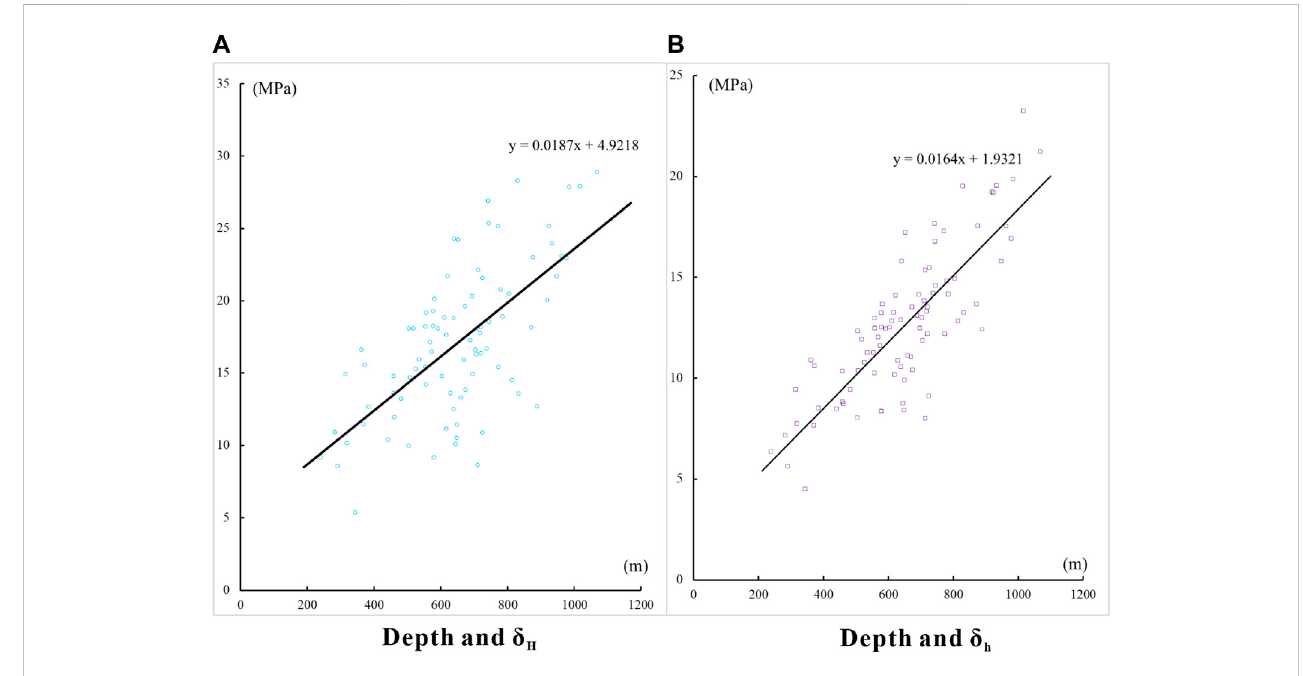
The relationship between depth and δ H (A) , depth and δ h (B) .